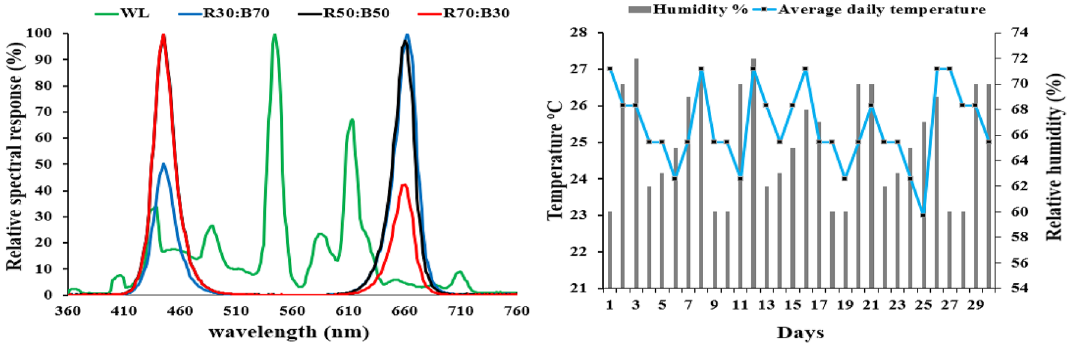
Figure 5. Spectrum distribution of the treatments LED light and in the experiment and environmental